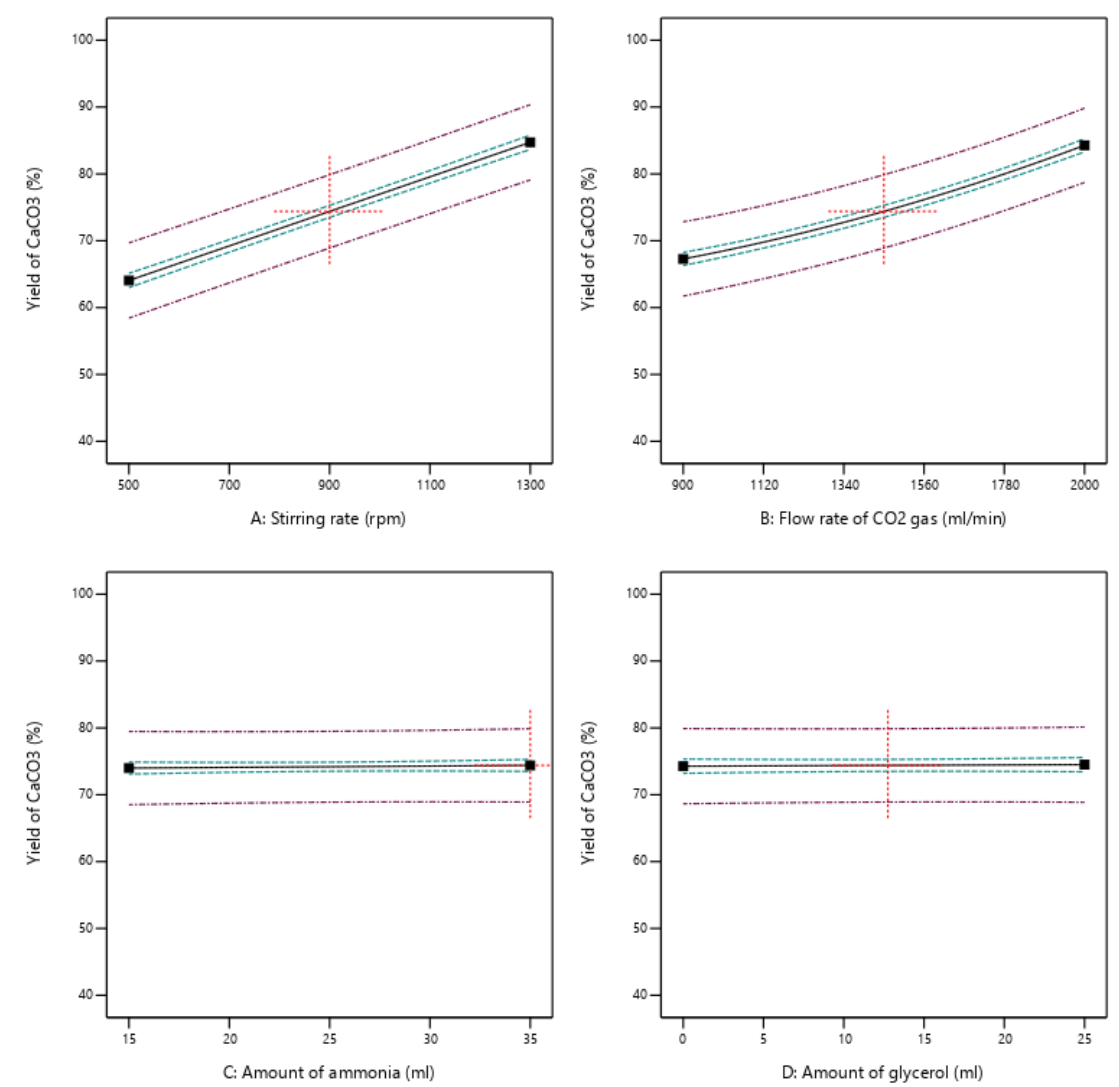
Figure 13. Process variables affect the CaCO 3 yield